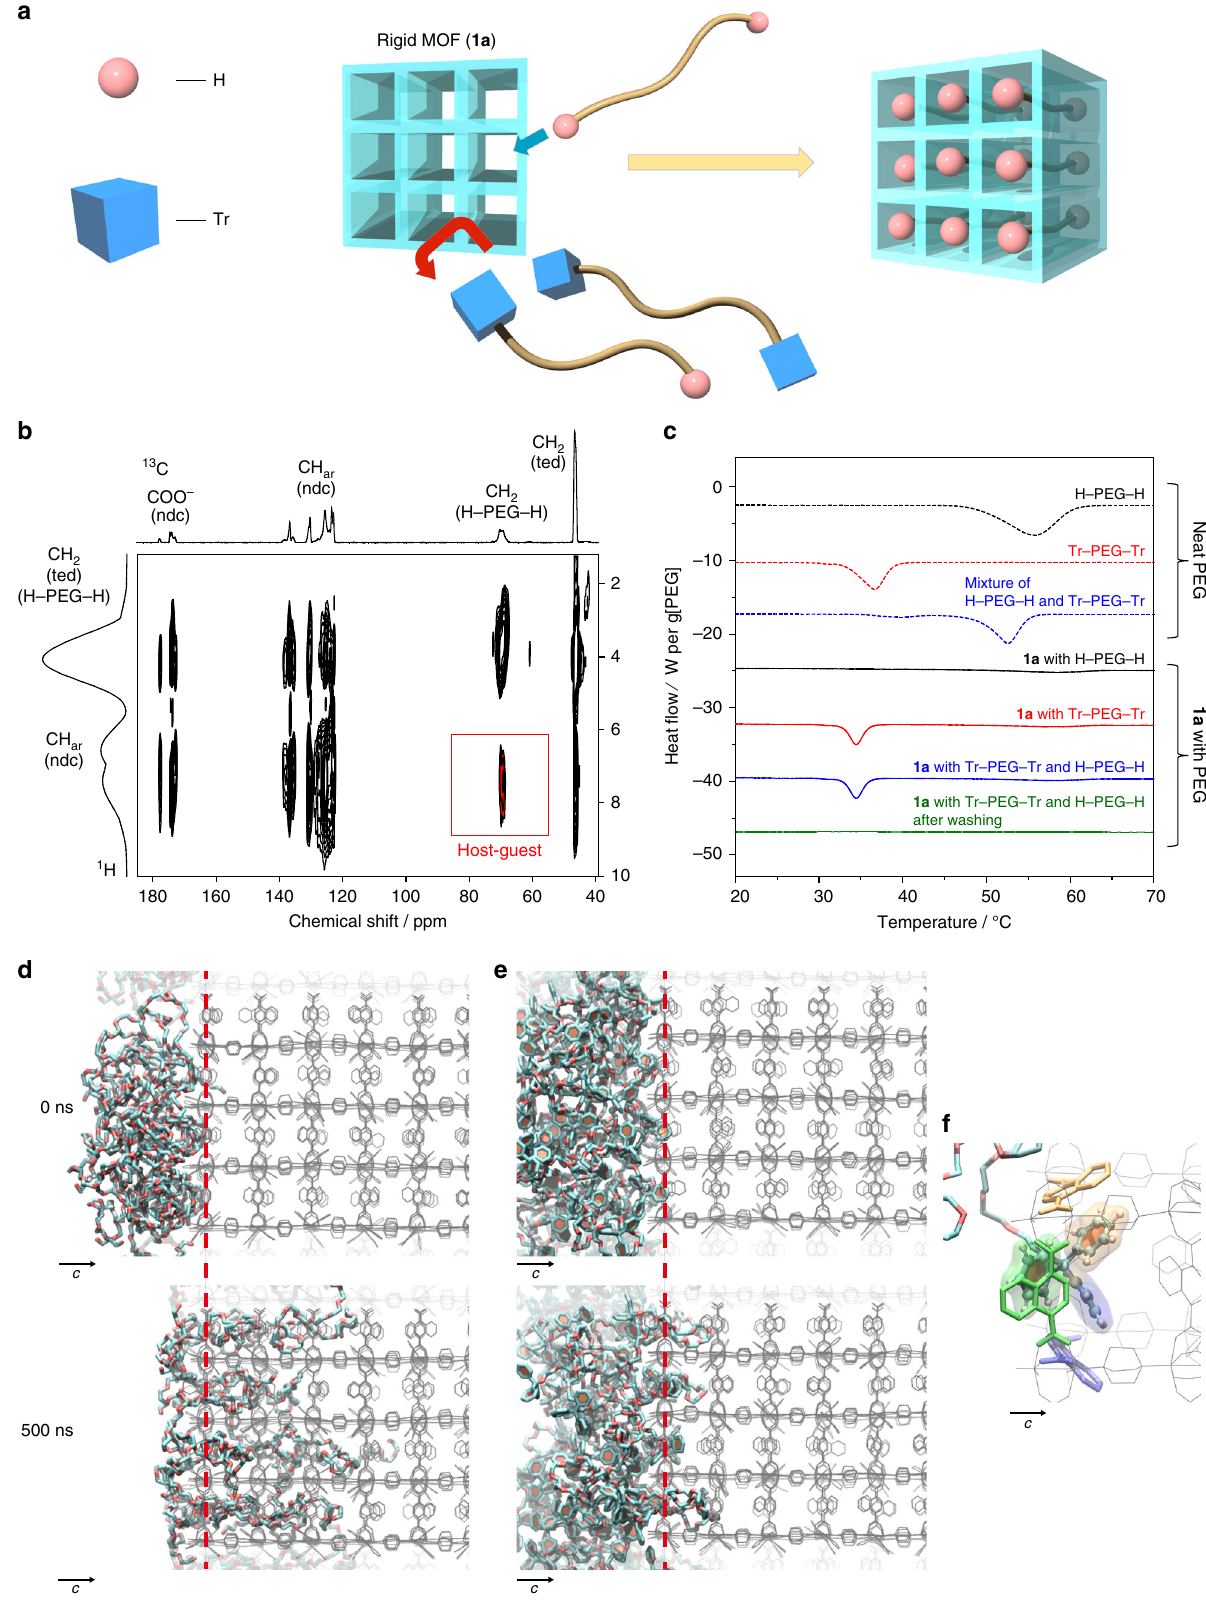
Fig. 1 Use of 1a for PEG separation. a Schematic for sorting polymers with different terminal groups using a rigid MOF. b 2-D 1 H – 13 C HETCOR NMR spectrum of 1a treated with H – PEG – H. c DSC heating curves of neat PEG (dotted line) and 1a after the heating treatment with PEG (solid line). H – PEG – H, Tr – PEG – Tr, mixture of H – PEG – H and Tr – PEG – Tr, and 1a with H – PEG – H and Tr – PEG – Tr after washing. M n of PEG used in these experiments was 2 kDa. d − f MD simulation snapshots of 1a with d H – PEG – H and e , f Tr – PEG – Tr at 373 K. MD structure of Tr – PEG – Tr near the surface ( f ) showed that selective exclusion of Tr – PEG – Tr was attributed to the steric hindrance of terminal groups as well as the π – π interaction between Tr groups and the